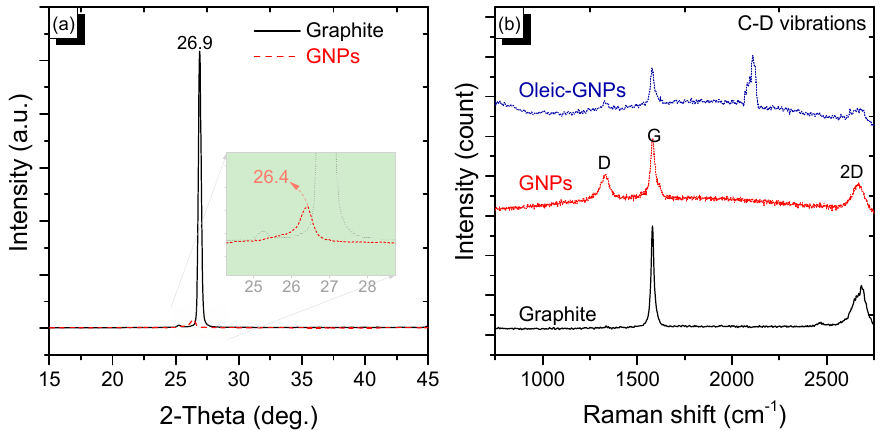
Figure 3. ( a ) X-ray diffraction (XRD) patterns of natural graphite (black line) and graphene nanoplatelets (red line) and ( b ) Raman spectrum of graphite (black curve), graphene nanoplatelets (red curve), and oleic-modified graphenenanoplatelets (GNPs, blue curve). The relative thickness of the GNPs can be calculated by atomic force microscopy (AFM) as shown in Figure 4a. The GNPs are not flat because of their crumpled structure that causes the upper graphene layers to protrude from the surface of the Si wafer (Si wafer is substrate to deposit GNPs for AFM measurement) [37]. Figure 4b and S2 exhibit the topographic AFM image of graphene nanoplatelets the height profile derived from the AFM image. The height profile between the GNPs and the Si substrate is utilized to relatively determine the thickness of the GNPs. The average calculated height is approximately 15 nm, which is approximately less than 30 layers considering the gaps between layers. This result is consistent with the aforementioned SEM, Raman, and XRD results on the multilayer nature of the resultant GNPs.